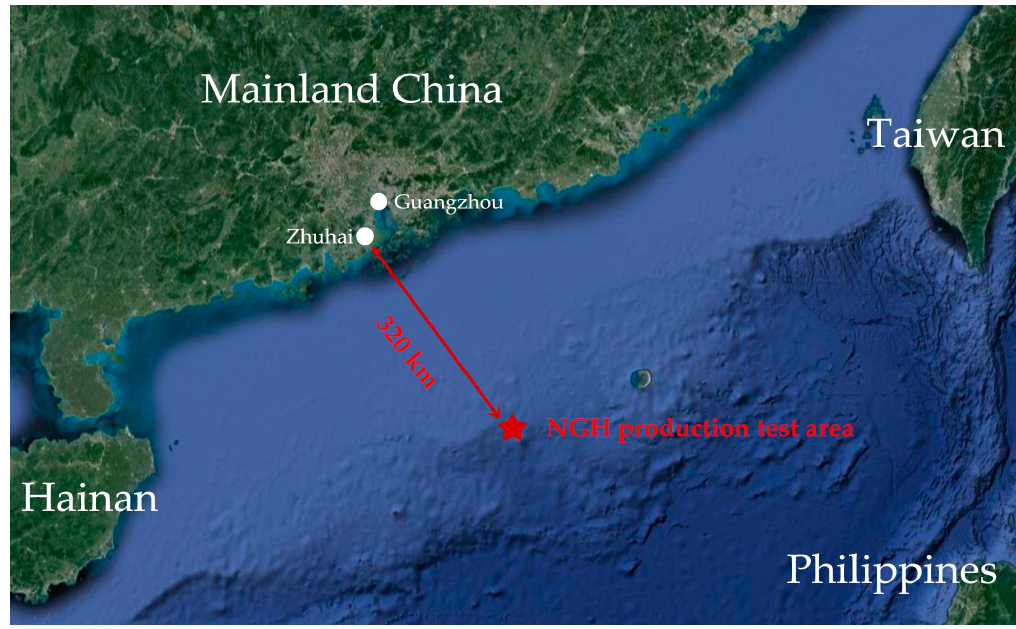
Figure 1. Location of natural gas hydrates (NGH) production test in the Shenhu area of the South China Sea.